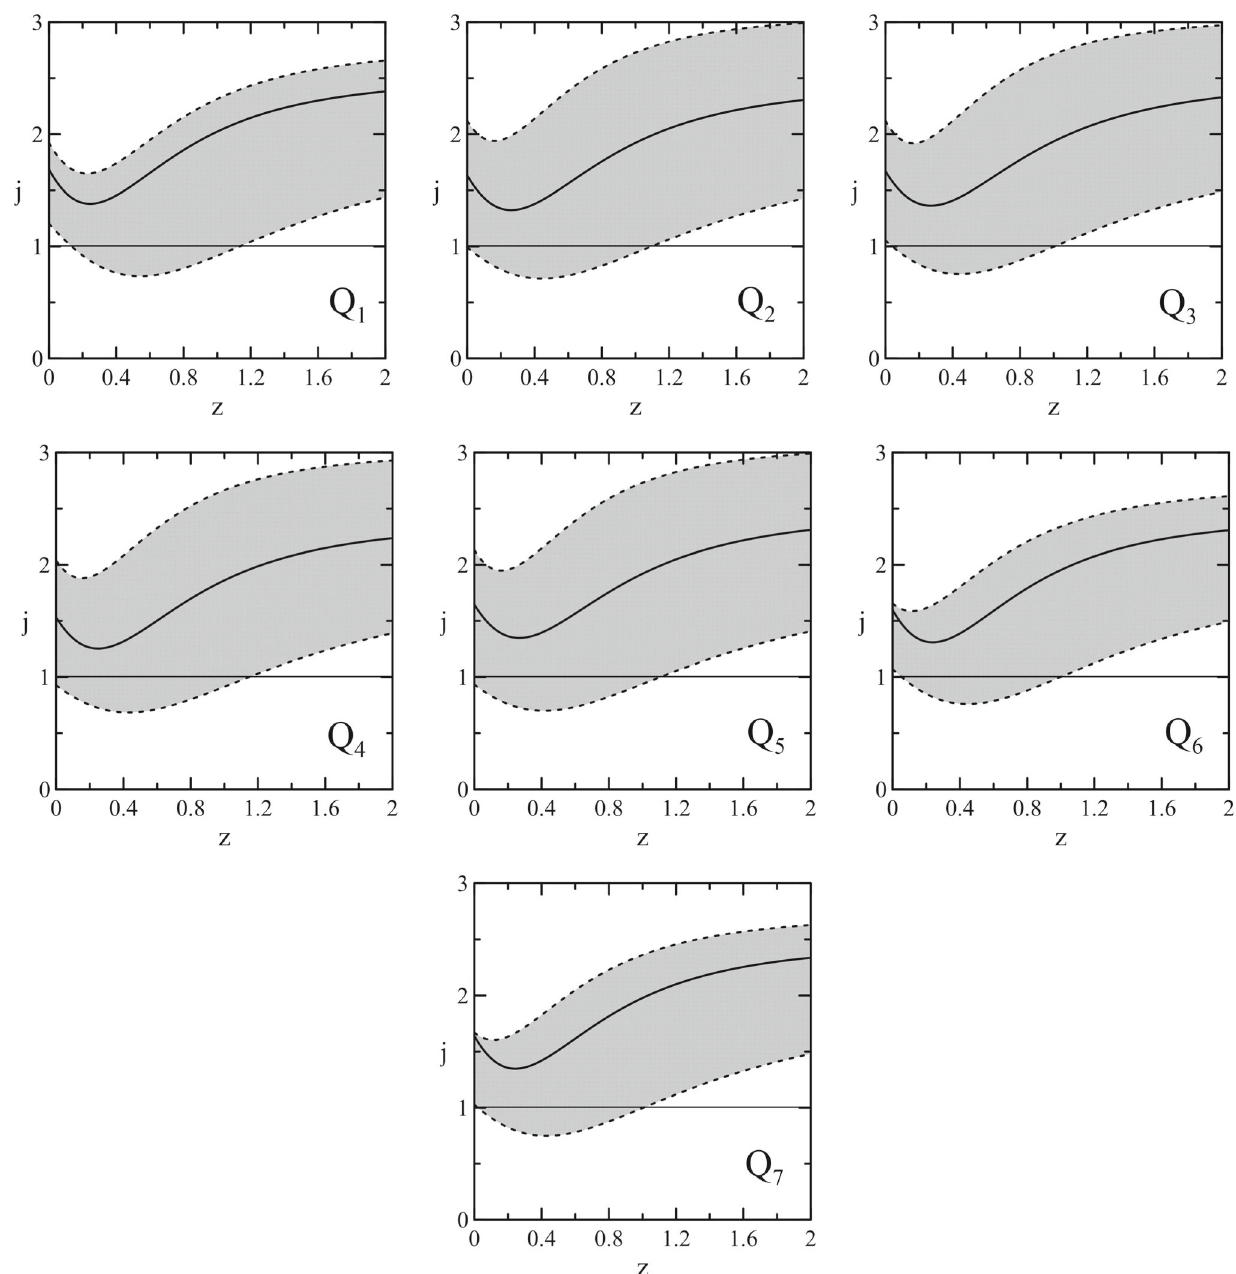
Fig. 3 The evolution of the jerk parameter in terms of redshift for HRDE model (Eqs. (15) and (16)) with the corresponding 1 σ interval level according to the best fitted value listed in Tables 2 and 3 and using